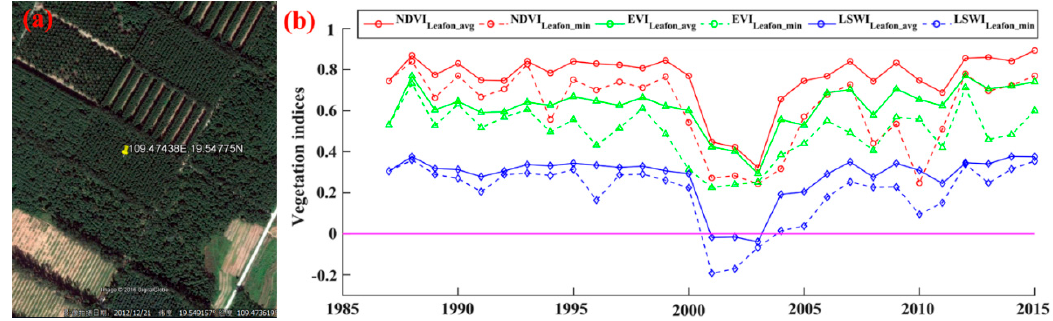
Figure 4 . Illustration of ( a ) rubber plantation in Google Earth VHR imagery and ( b ) it’s temporal profile of mean and minimum NDVI, EVI, and LSWI from annual composited Landsat images acquired in leaf-on period. This rubber plantation was on an experimental farm of the Chinese Academy of Tropical Agricultural Science (CATAS), and new rubber plantations were established after removing the old rubber trees in 2001.